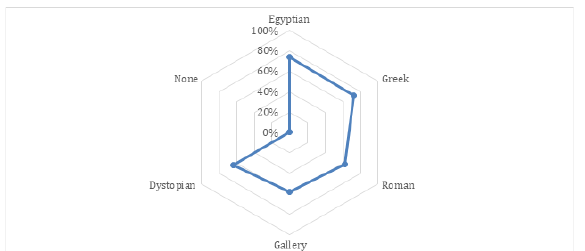
Figure 13. Evaluation graphic: which section did you